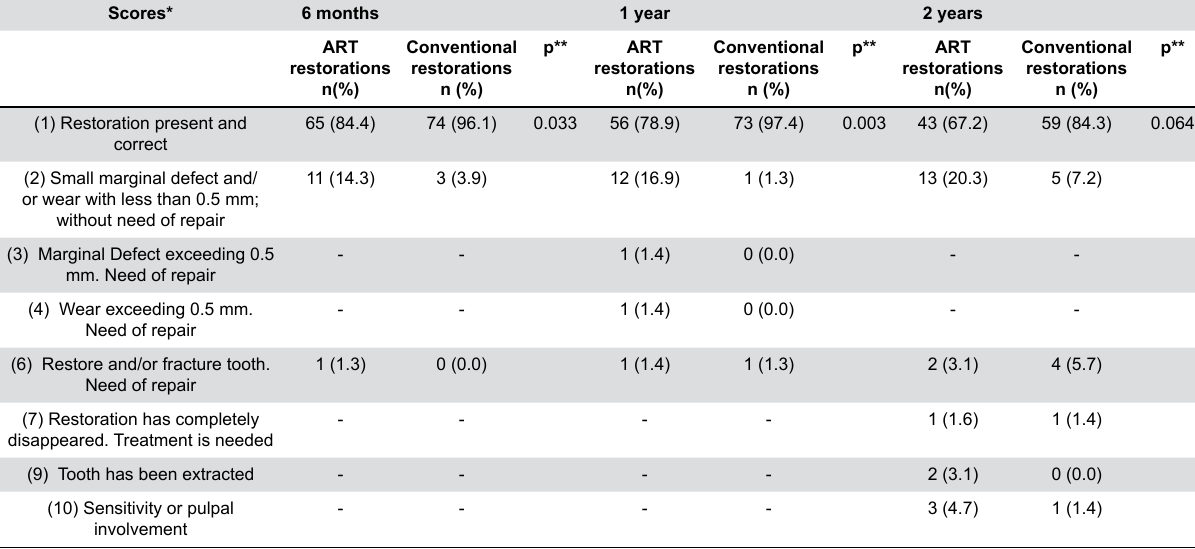
Table 1- Distribution of scores according to the ART criterion for ART restorations with HVGIC and conventional restorations with resin